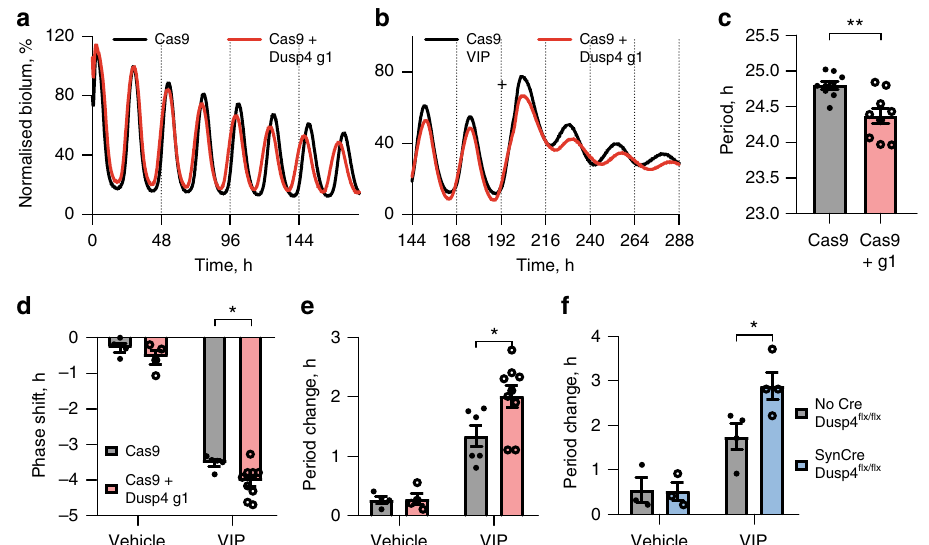
Fig. 7 Dusp4 knockout shortens circadian period and potentiates the VIP response of SCN slices. a , b Representative PER2::LUC bioluminescence rhythms of slices transduced with Mecp2.SpCas9 alone or in addition to U6.Dusp4g1.hSyn.GFP-KASH before treatment ( a ) or with 1 µ M VIP application ( b marked by plus). Bioluminescence has been normalised to the fi rst peak. c Group data for steady-state period of slices transduced as in ( a ) (mean ± SEM, n = 9 per group, unpaired t -test). d , e Group data for phase shifts ( d ) and period changes ( e ) following vehicle or VIP of slices transduced as in a (mean ± SEM, n = 4 for all vehicle-treated groups, n = 6 for Cas9 with VIP, n = 9 for Cas9 + Dusp4 g1 with VIP). f Group data for period change of Dusp4 fl x/ fl x SCN slices transduced with hSyn.GFP::Cre AAV and treated with vehicle or VIP, along with non-transduced controls (mean ± SEM, n = 3 for all vehicle-treated groups, n = 4 for all VIP-treated groups). Two-way ANOVA with Sidak ’ s multiple comparisons. * P < 0.05, ** P <